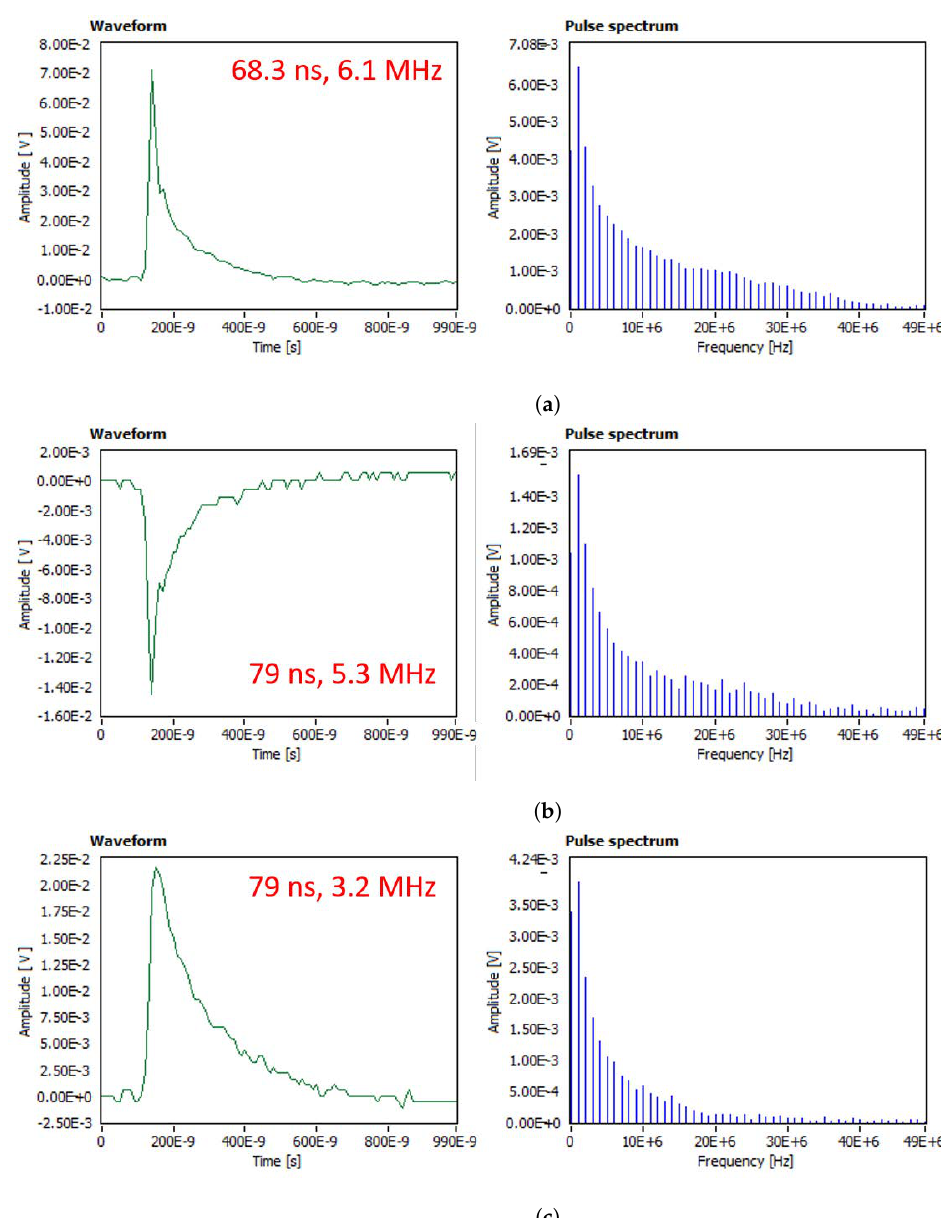
Figure 9. High temperature discharge pulse waveforms and corresponding frequency spectra. T 2 , W 2 coordinates of each pulse are shown on the time domain graphs. ( a ) AC pulse. ( b ) Negative DC pulse. ( c ) Positive DC